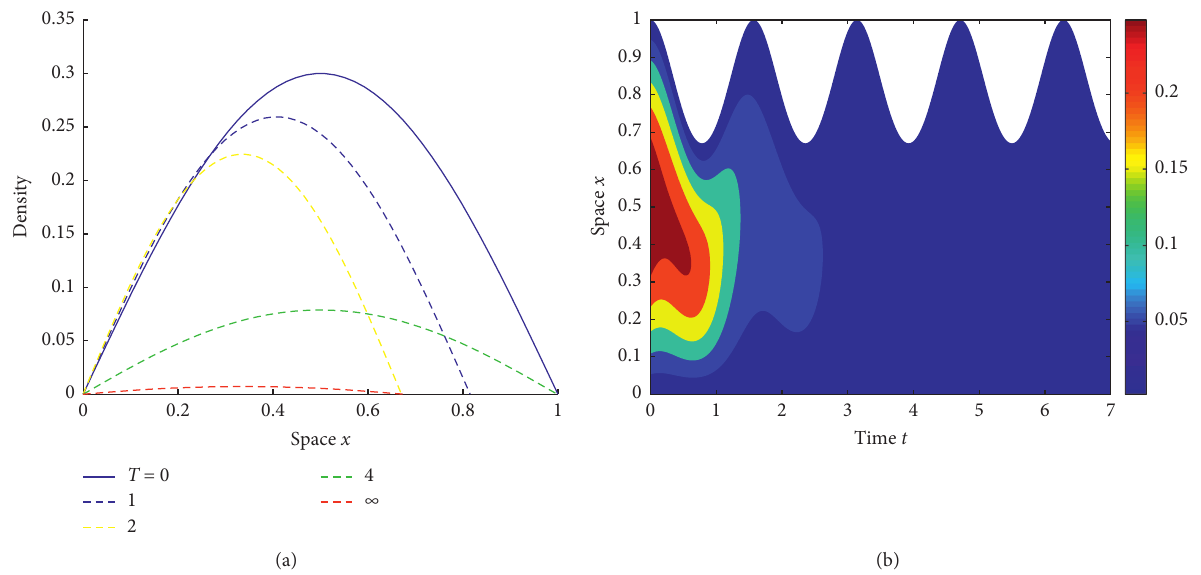
Figure 8: The corresponding cross-sectional view (a) and contour one (b) for the solution of problems (7) and (9), which implies that the domain is not periodically evolving when the evolution rate ρ ( t ) � e 0 . 2 ( cos ( 4 t )− 1 )